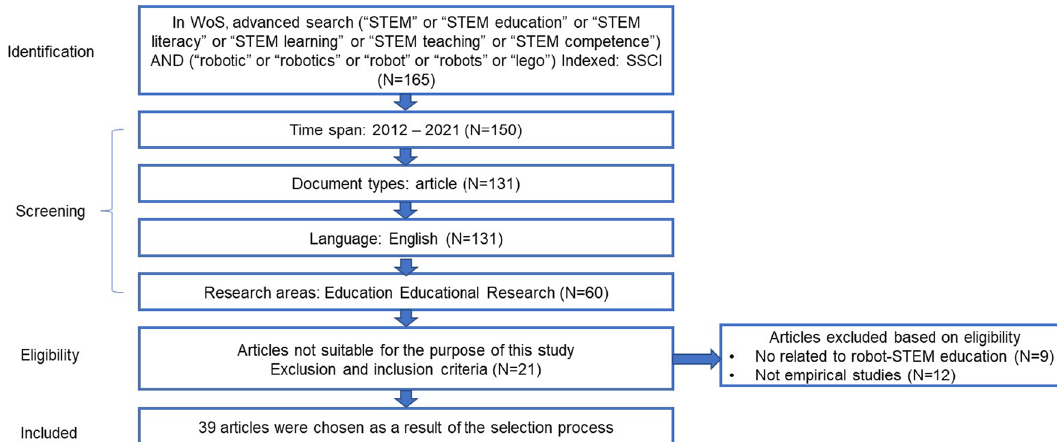
Fig. 1 PRISMA procedure for the selection process